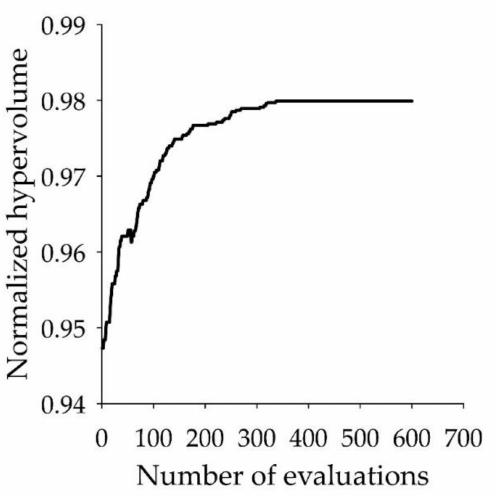
Figure 16. The convergence of the NSGA-II